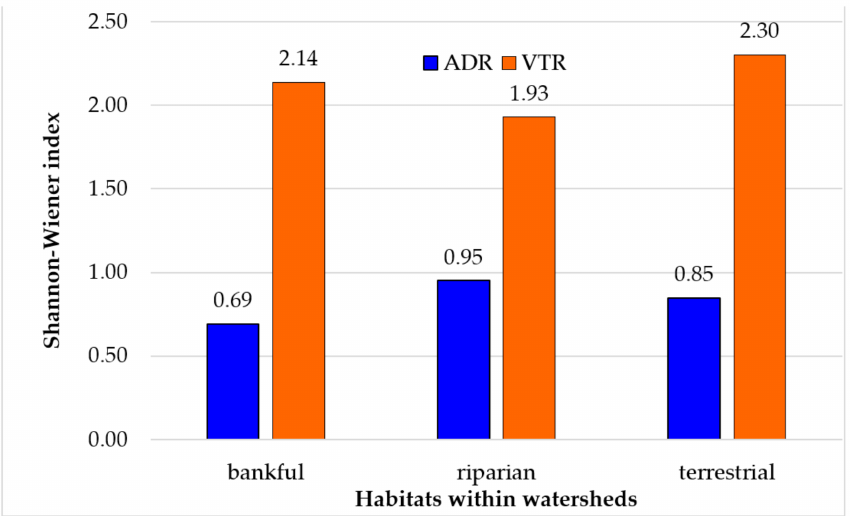
Figure 9. The Shannon–Wiener diversity index for the different habitats (bankfull, riparian and terrestrial) where insects were collected for Arkoudorema (ADR) (blue column) and Vathirema (VTR) (orange